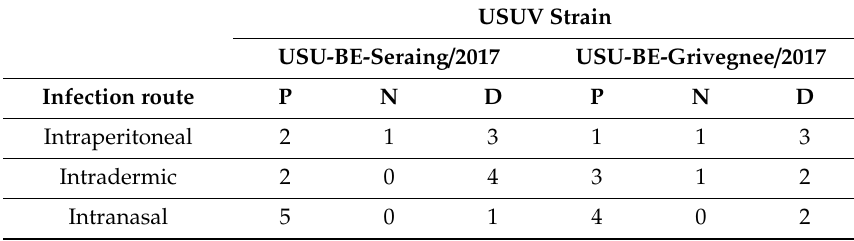
Table 1. Antibody response against USUV infection tested by competitive ELISA in experimentally infected